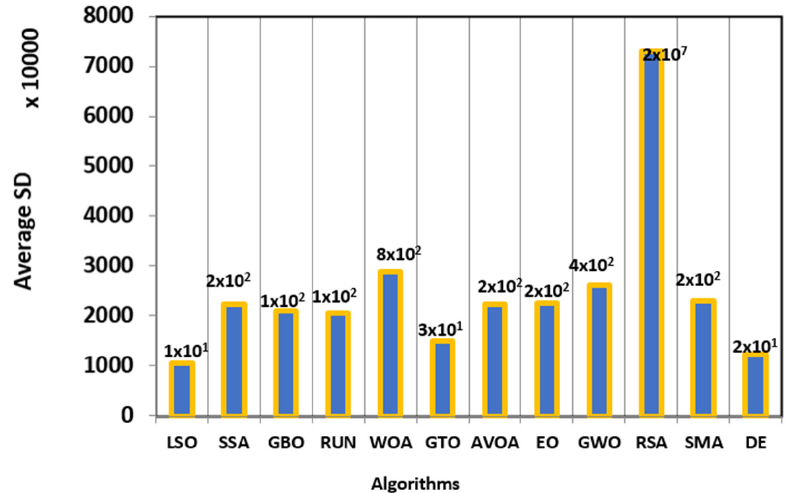
Figure 15. Average rank of each optimizer on all CEC2022.